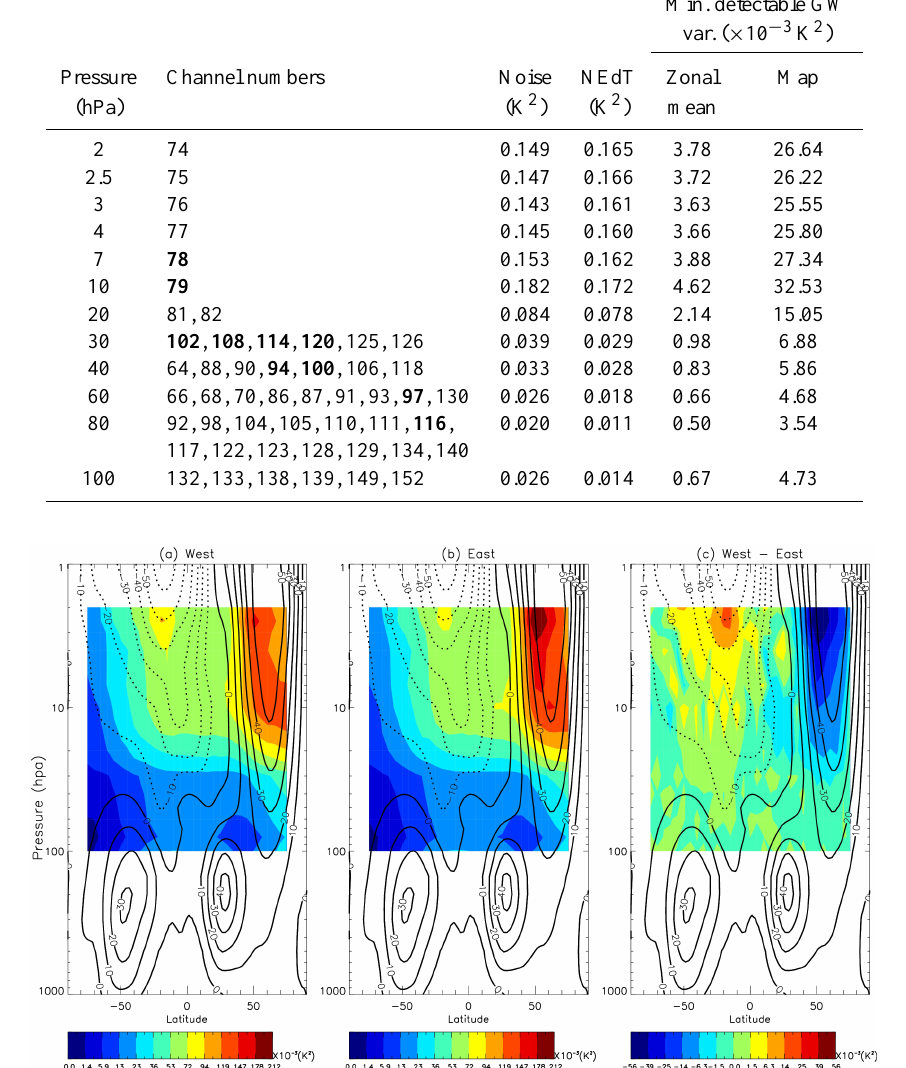
Fig. B1. Same with Fig. 3, but 3-pt filter is applied instead of 7-pt filter. Figure B 1. Same with Fig. 3, but 3-pt filter is applied instead of 7-pt filter. absolute temperature perturbation, while T 0 is the back- ground temperature. The overbars denote the column aver-